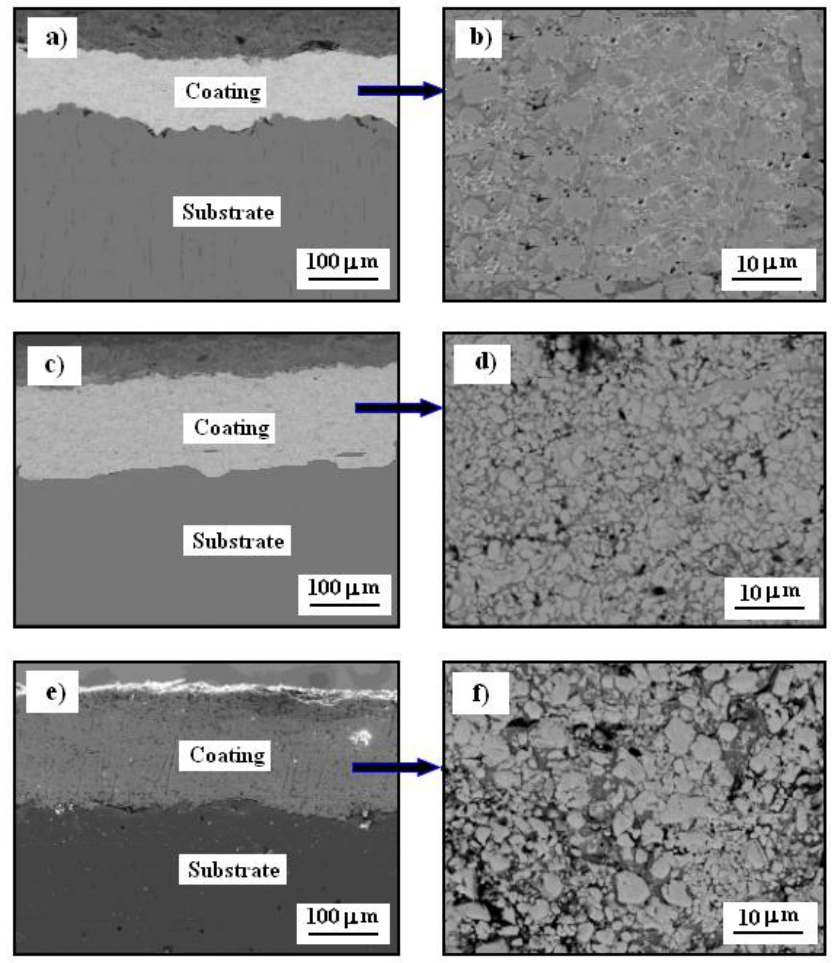
Figure 6. SEM cross-section imagesof the Cr 3 C 2 -25(Ni20Cr) cermet coatings on the Al7075 substrate after laser remelting for the spot speed: ( a , b ) 600 mm/min, ( c , d ) 800 mm/min, and ( e , f ) 1000 mm/min.